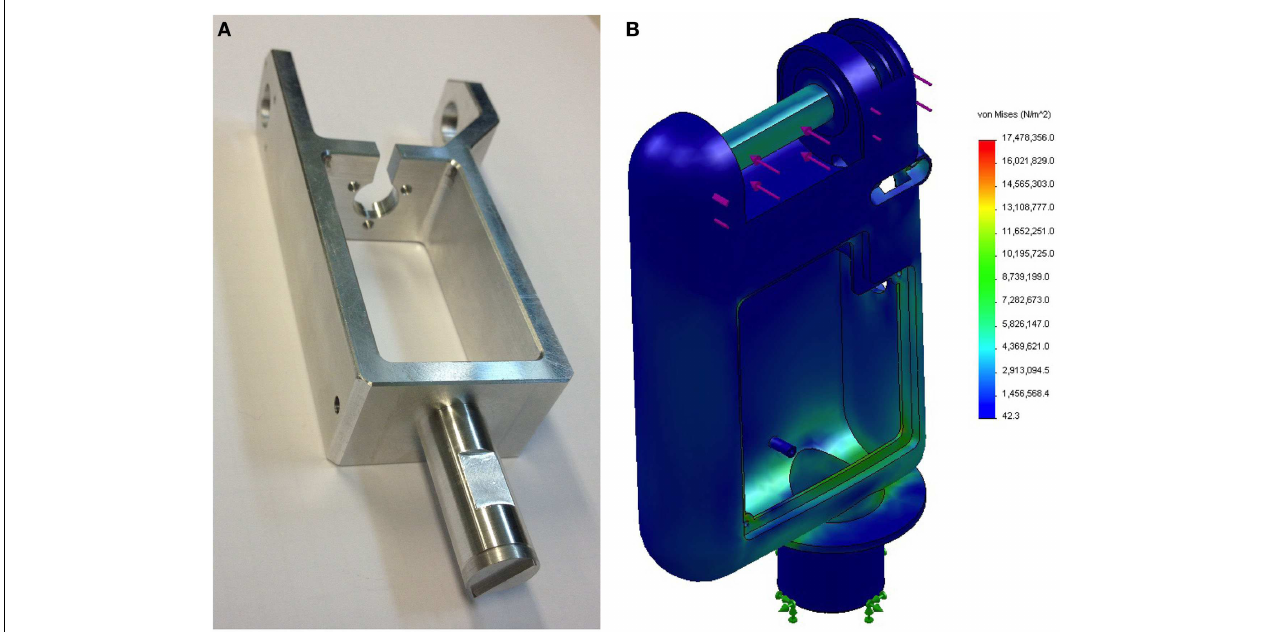
FIGURE 7 | The development of the neck design : (A) Original metal design. (B) New 3D-printed FEM of the